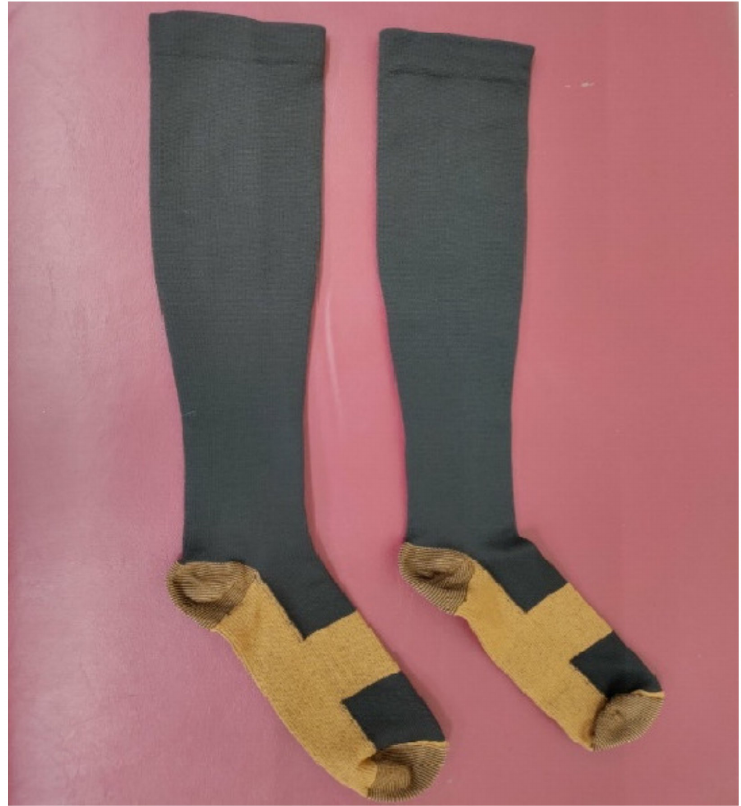
Figure 1. An example of the clinical (left) and sub-clinical (right) compression sock used in the